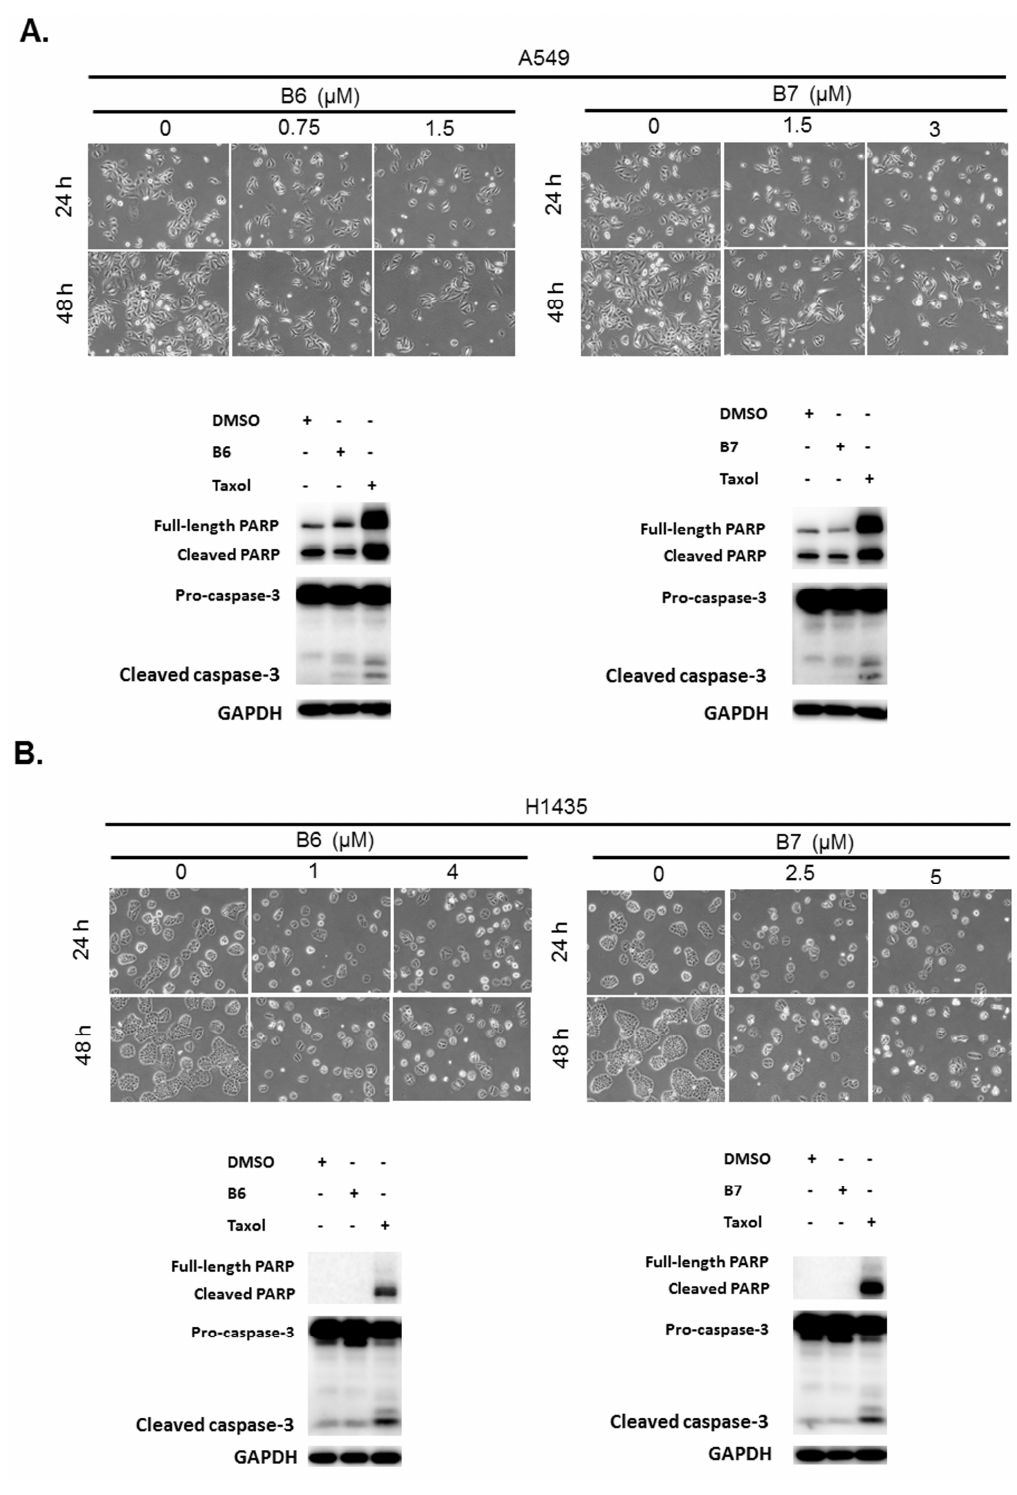
Figure 3. Cellular apoptosis profile in non-small-cell lung cancer cells under B6 and B7 treatment. ( A ) A549 and ( B ) H1435 cells were treated with control medium or B6 and B7, and the cellular morphology was determined under microscopy. Total cell lysate was extracted after 24-h incubation, and the expressions of caspase-3 and PARP were determined by western blotting. DMSO was used as a negative control, and Taxol was used as a positive control. GAPDH was used as a loading control. Three independent experiments were conducted.